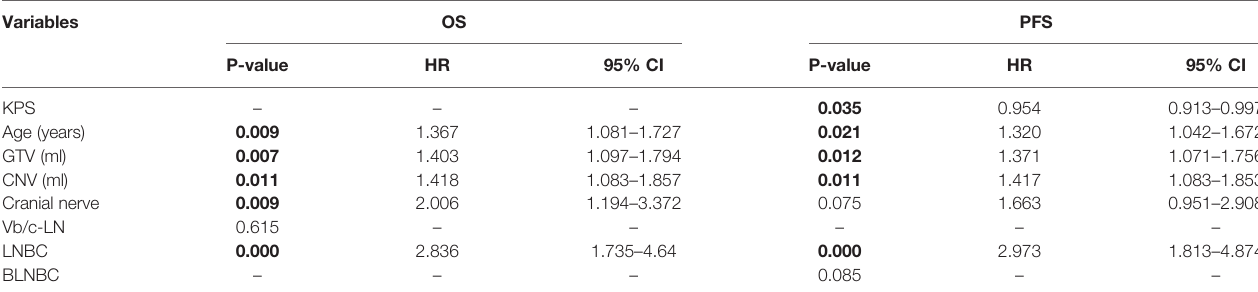
TABLE 2 | Multivariate Cox regression analyses for OS and PFS in NPC patients in the training set.